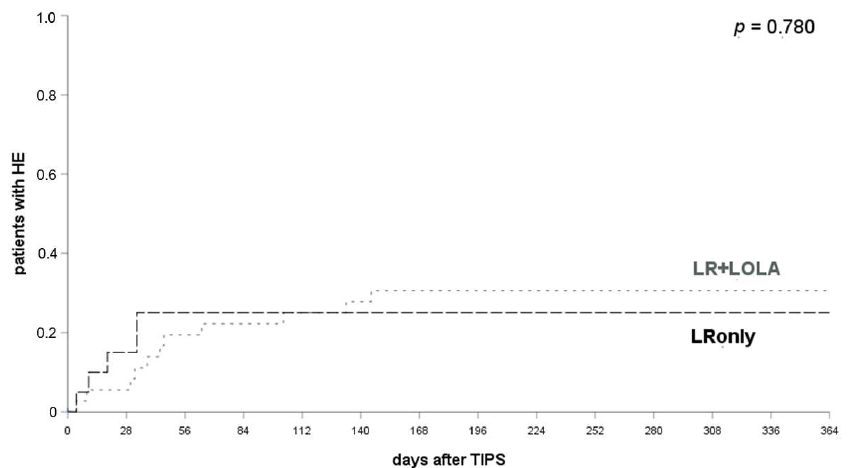
Figure 4. Comparison of HE occurrence in patients with LRonly or LR + LOLA for HE prophylaxis. HE occurred in 20.0% of patients with LRonly and 21.6% of patients with LR + LOLA at 1 month ( p = 0.815), 25.0% and 25.0% at 3 months ( p